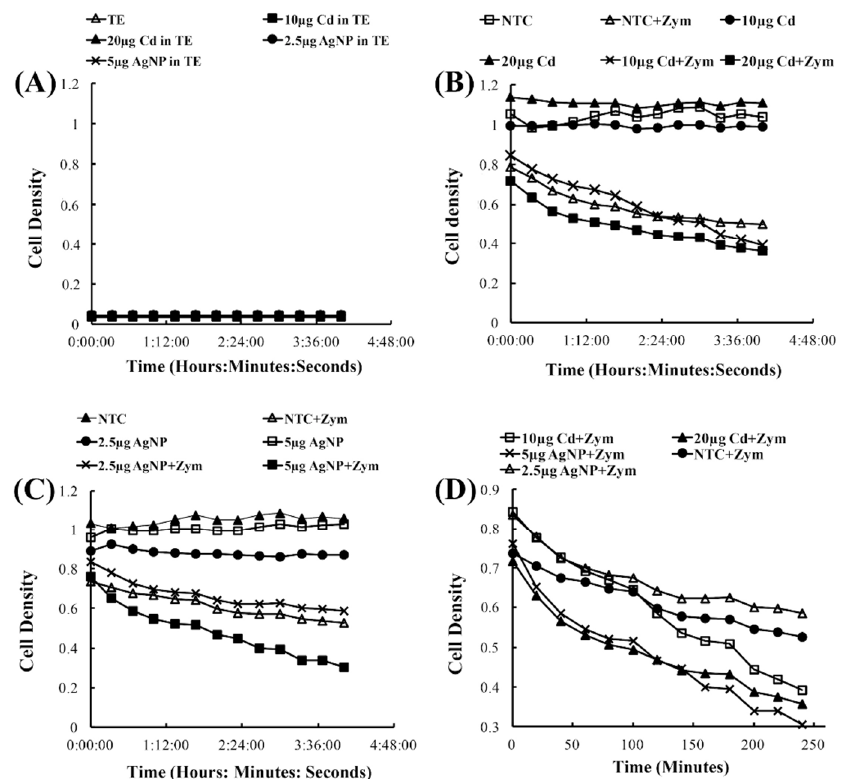
Figure 5. Cell wall viability assay to determine the e ff ects of AgNPs or CdSe / ZnS-QDs on yeast cells lacking cell walls via Zymolase treatment. ( A ) The optical densities of the nanomaterials in TE bu ff er without yeast cells were measured at a wavelength of 594 nm for four hours while shaking at 30 ◦ C. ( B ) The cell density of yeast cells when treated with di ff ering concentrations of CdSe / ZnS (10 and 20 µ g / mL), with or without Zymolase (non-Zymolase-treated cells did not show a significant change in optical density over time). ( C ) Cell density measurements of yeast cells when treated with di ff erent concentrations of AgNPs (2.5 and 5 µ g / mL), with or without Zymolase. ( D ) Rearrangement of optical densities from Zymolase-treated cells in Figure 5B,C. The non-treated control with Zymolase (filled circle) was compared with 2.5 (empty triangle) and 5 (X symbol) µ g / mL AgNP-treated cells, and 10 (empty square) and 20 (filled triangle) µ g / mL CdSe / ZnS-treated